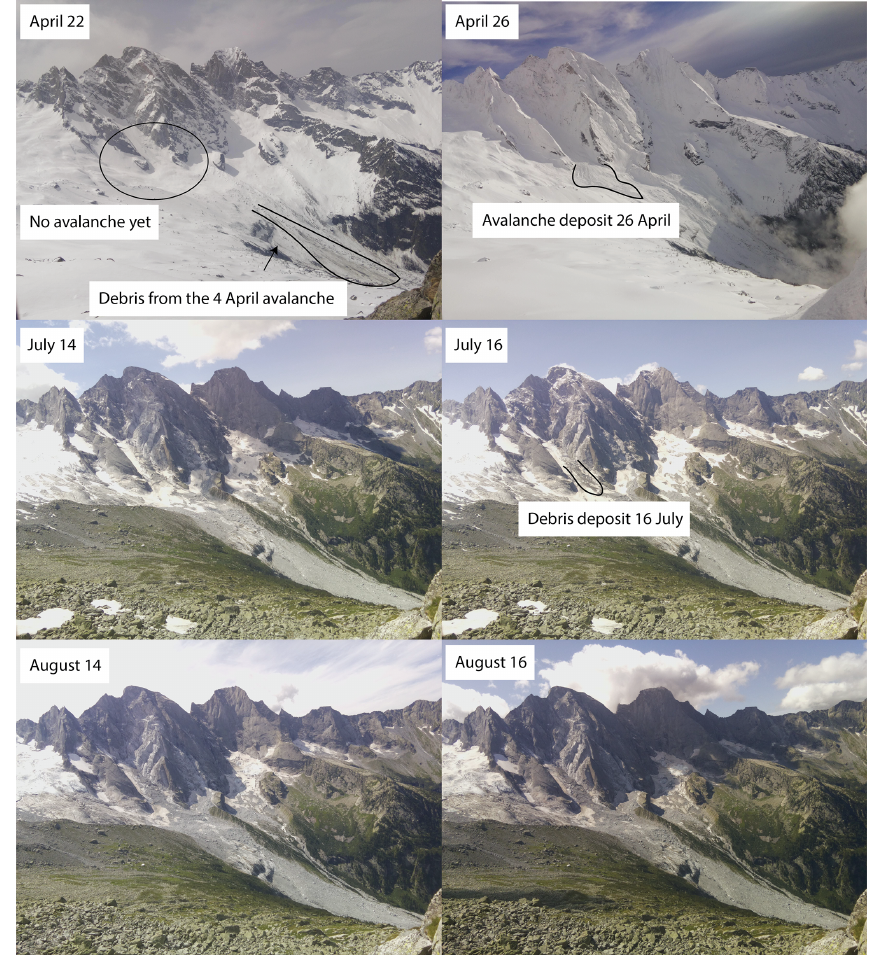
Figure 8. Automatic-camera photos of slope failures in 2019. Photos from April show the avalanche deposits from the events classified as slope failures of 4 and 26 April. Photos from July and August are from before and after the events of 16 July and 14 August. For the 14 August event, no deposit is visible on the